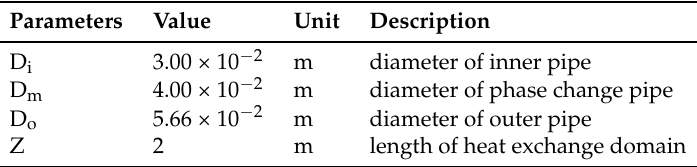
Table 1. Geometric parameters of heat